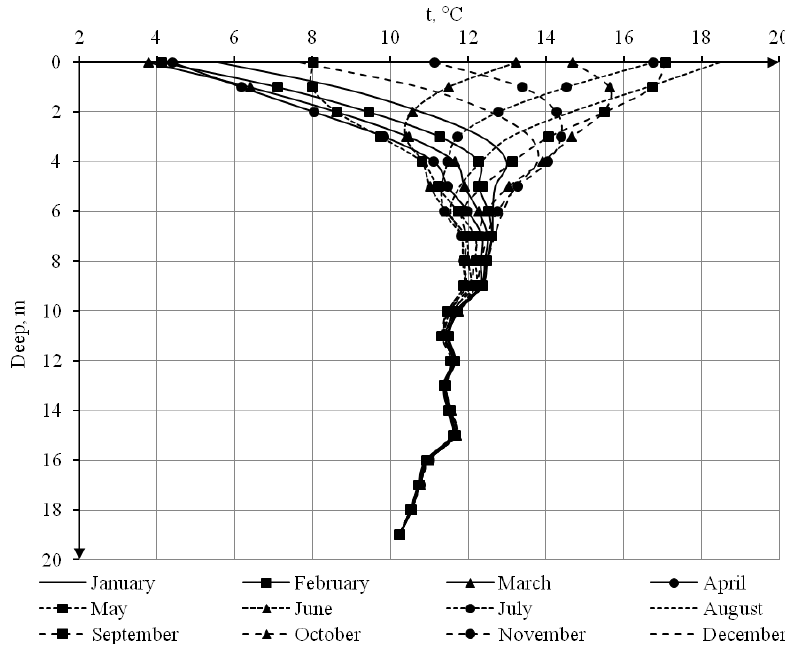
Figure 2. Site 1. Diagram of average monthly temperatures of soil mass according the monitoring results from 2009 to 2016